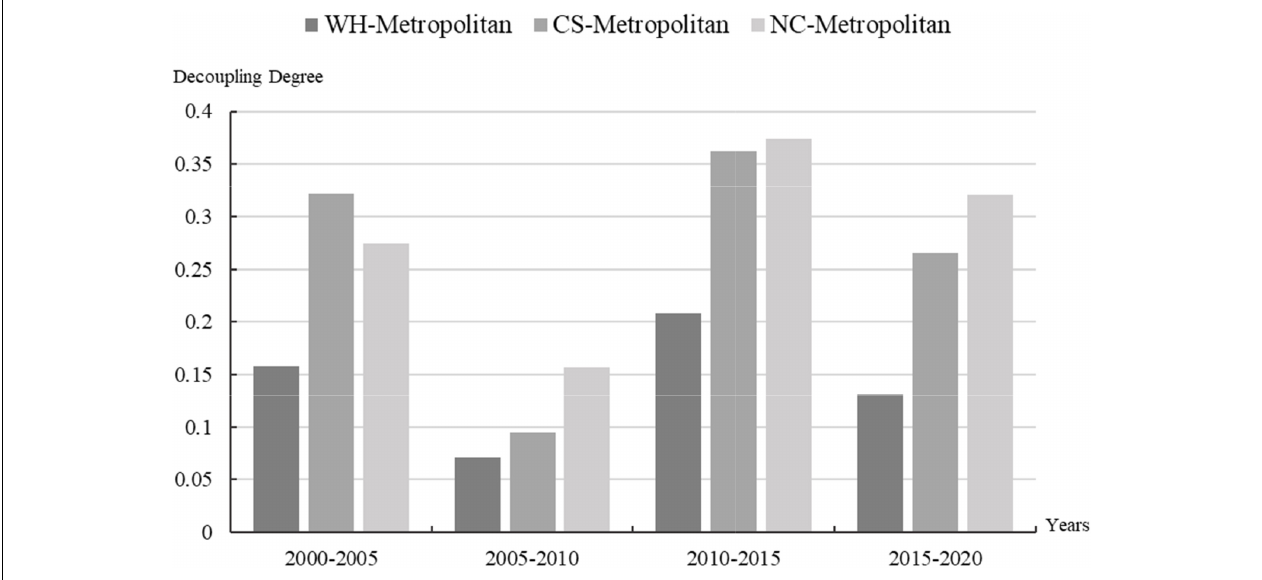
FIGURE 7 | Change in the decoupling degree of “construction land–economy” in the three metropolitan regions from 2000 to 2020.